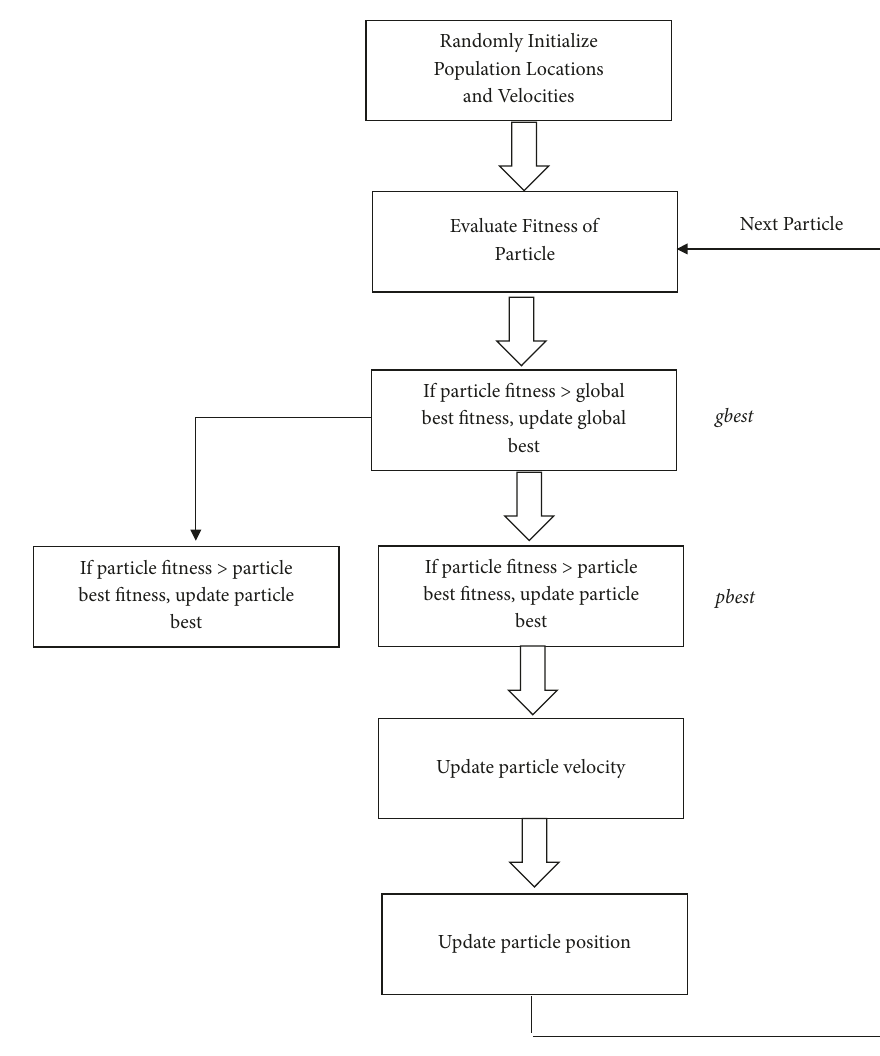
Figure 3: Basic PSO procedure